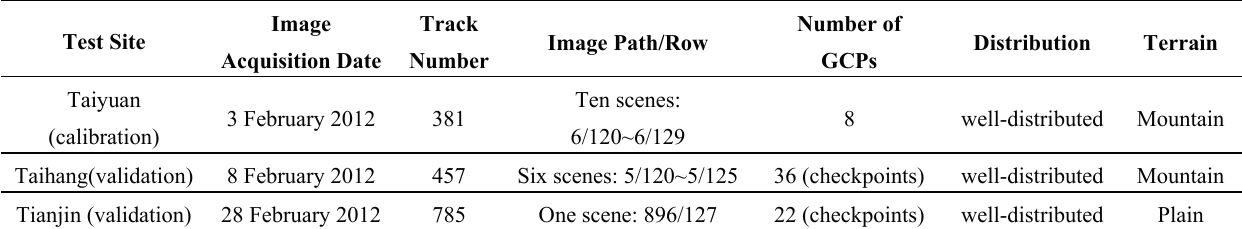
Table 1. Calibration/Validation site and test